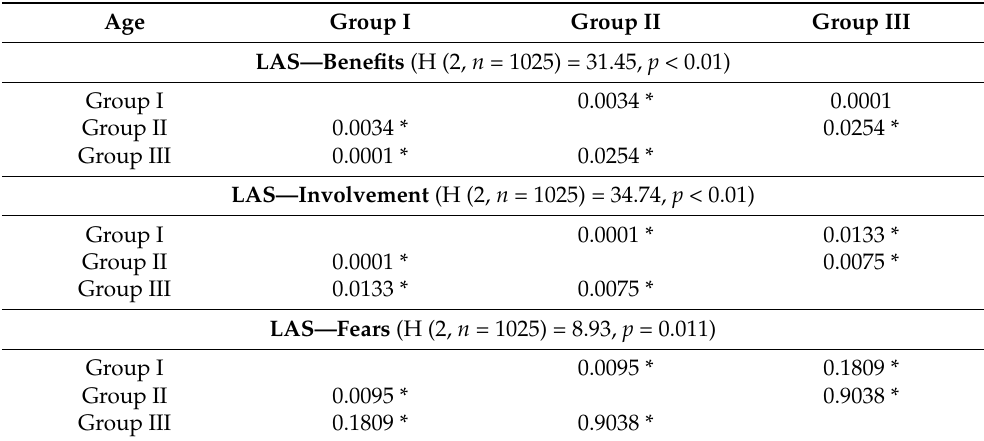
Table 3. The significance of the differences between age groups—results of post-hoc analysis.